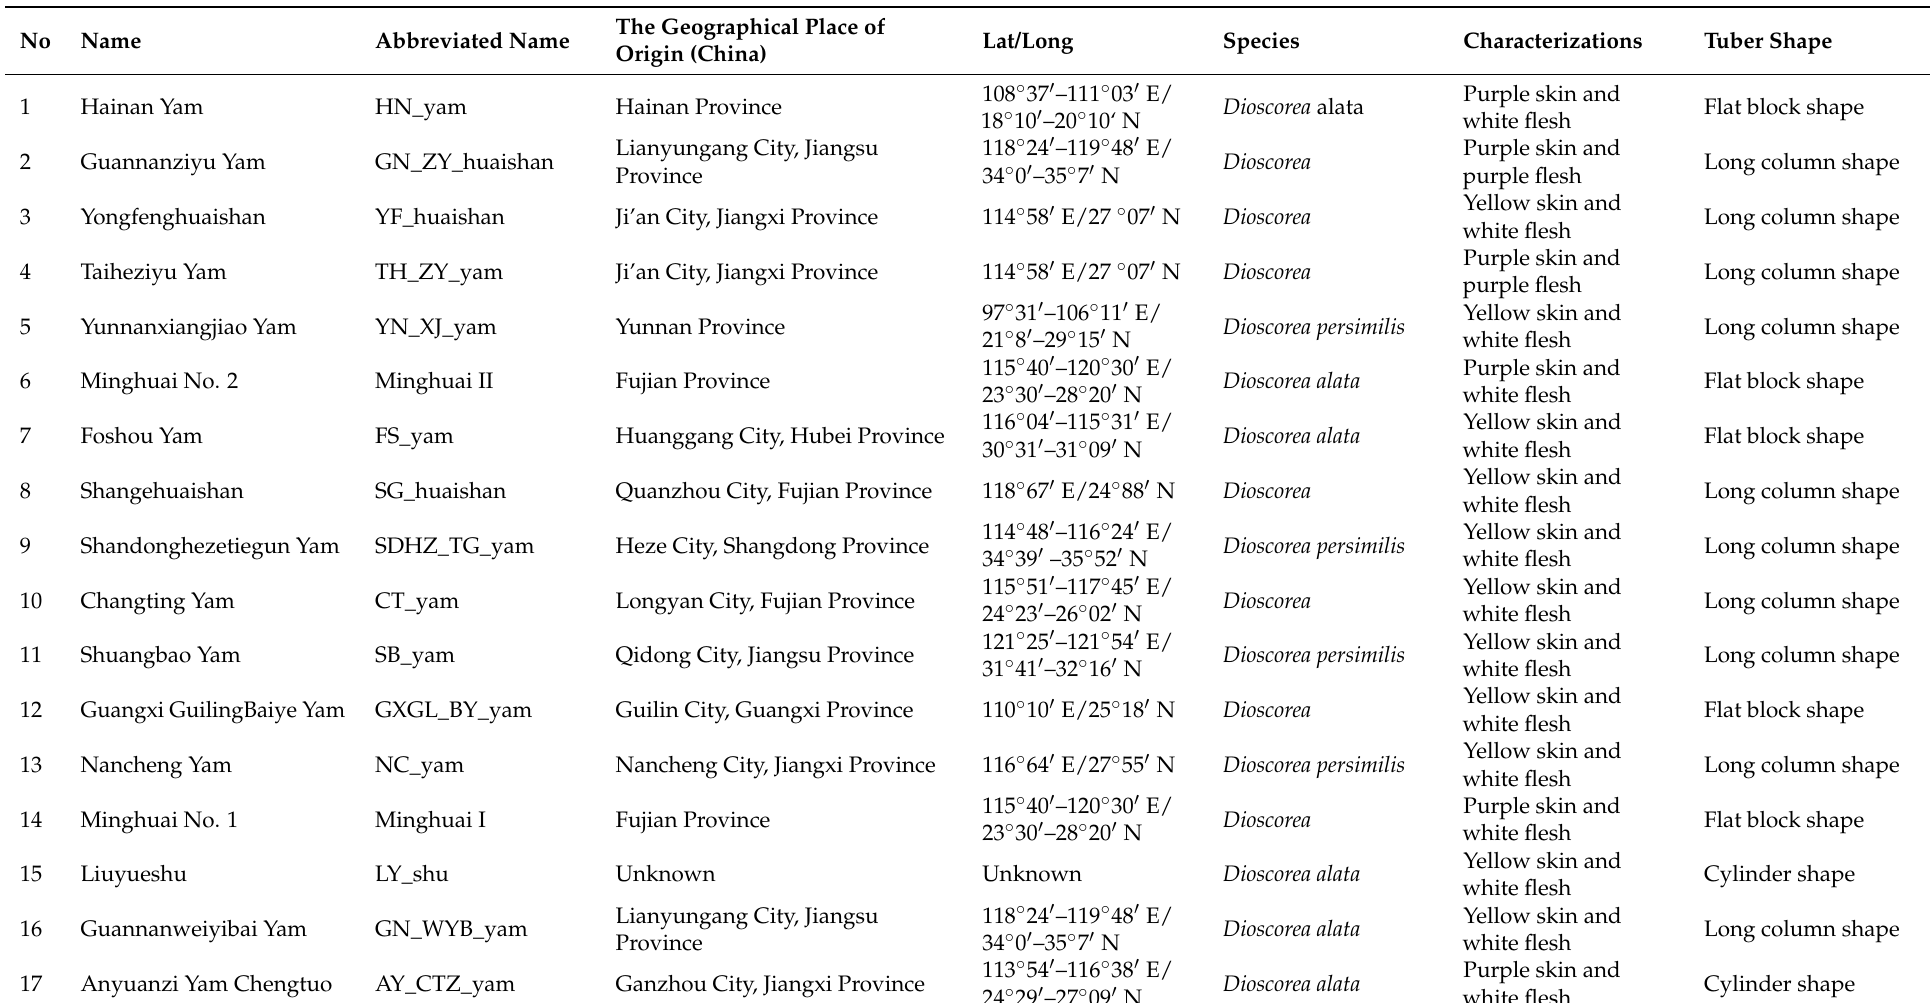
Table 1. List of experimental